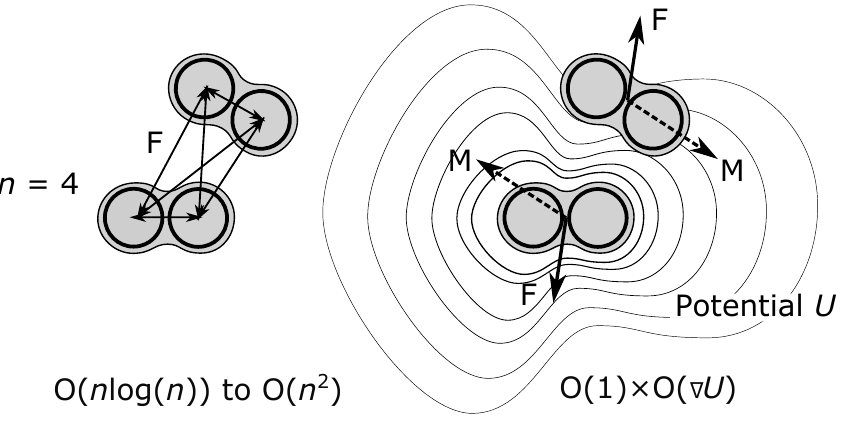
Figure 2. Effect of macromolecule abstraction as anisotropic beads with interaction potential on computational complexity ( n is number of atoms, neglecting solvent and ions). Note that a single interaction of HBcAg 2 is equivalent to n = 9432 and further increased by the solvent atoms ( n ≈ 10 5